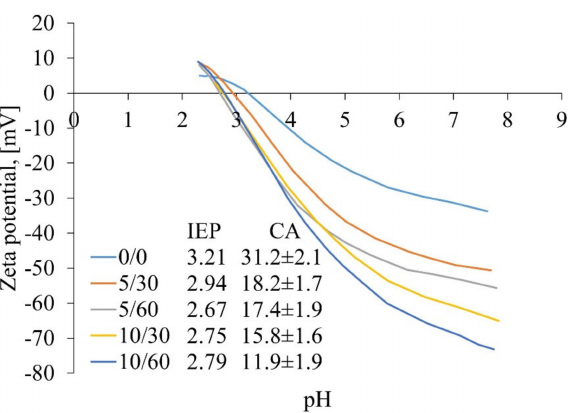
Figure 5. The zeta potential curves and isoelectric points (IEPs) of prepared membranes, recorded using a SurPASS electrokinetic analyser with the adjustable gap cell method and using 0.001 M KCl solution as an electrolyte; the contact angle values of the prepared membranes were recorded using the captive bubble method with KSV CAM 101 equipment connected to a CCD camera.